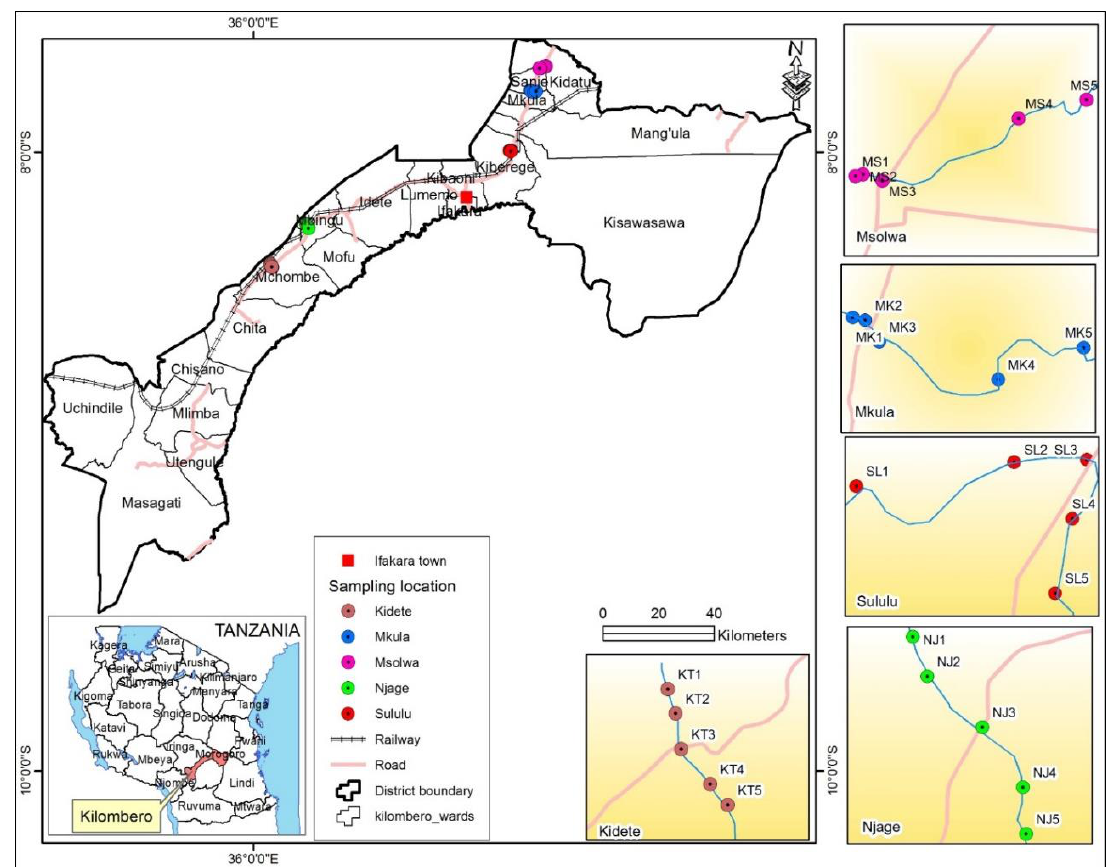
Figure 1. Map of Kilombero Valley, Tanzania, indicating sampling sites along the five streams: Msolwa (MS), Mkula (MK), Njage (NJ), Sululu (SL) and Kidete (KT). Each stream was sampled for physical-chemical parameters and macroinvertebrates at five sampling sites. Site 1 was located at the upper most part of the stream and Site 5 was located lowest downstream.